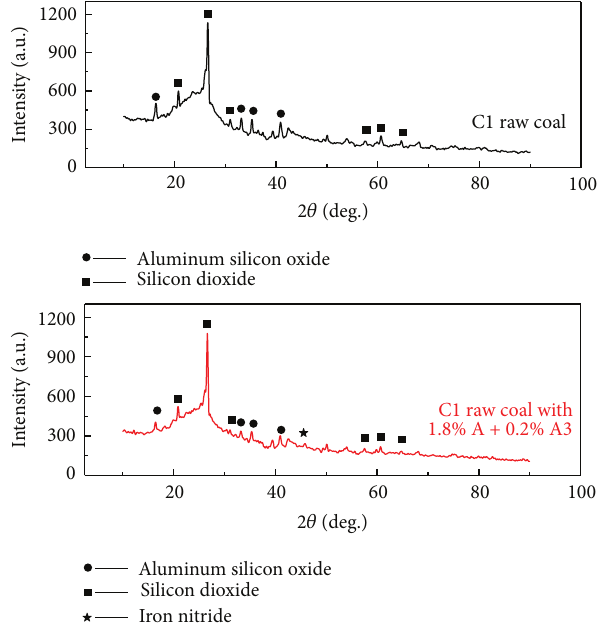
Figure 9: The XRD of combustion